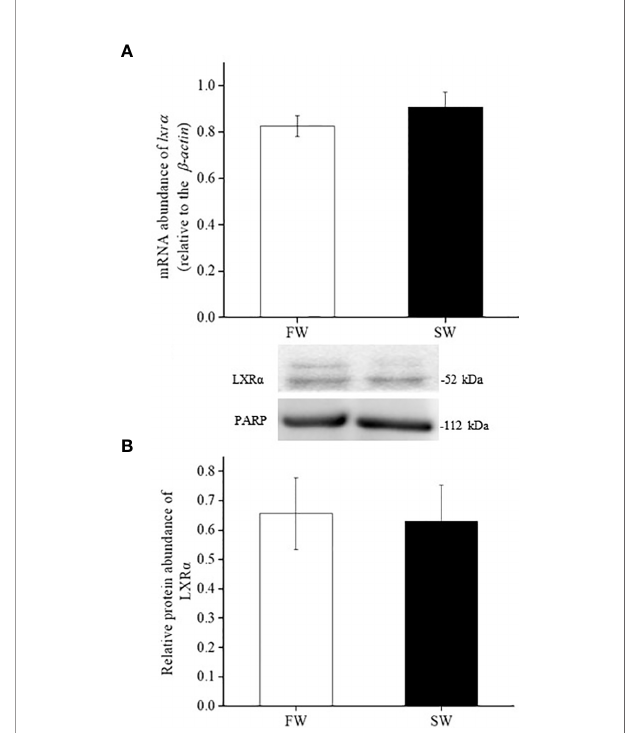
FIGURE 3 | Relative gene (A) and protein (B) expression of LXR a in livers of fresh water (FW) and seawater (SW)- acclimated Indian medaka. mRNA expression was analyzed by real-time PCR. The immunoblots were used to detect the protein expression. Values are mean ± S.E.M. (N =